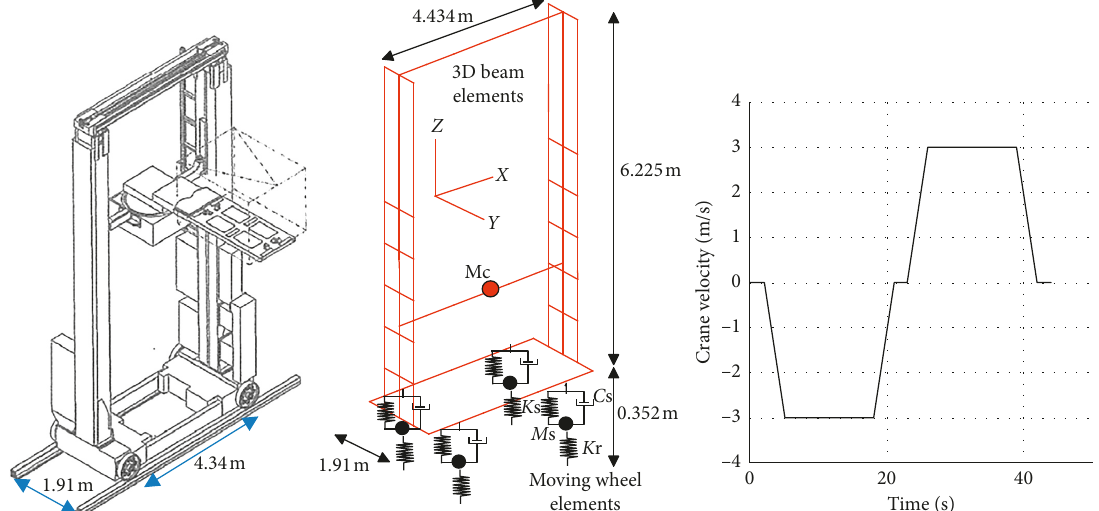
Figure 4: Dimensions, speed, and finite element model of the moving crane used in this study ( Mc 1.2E5kN/m, and Cs